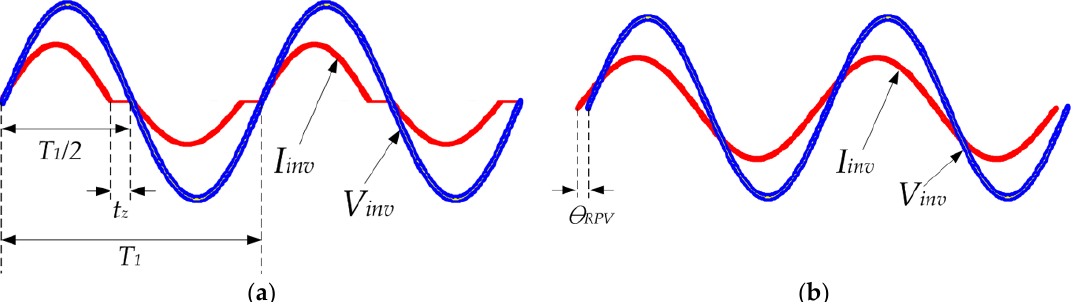
Figure 1. Voltage and current waveforms for the typical anti-islanding methods. ( a ) The AFD method, ( b ) the RPV method.